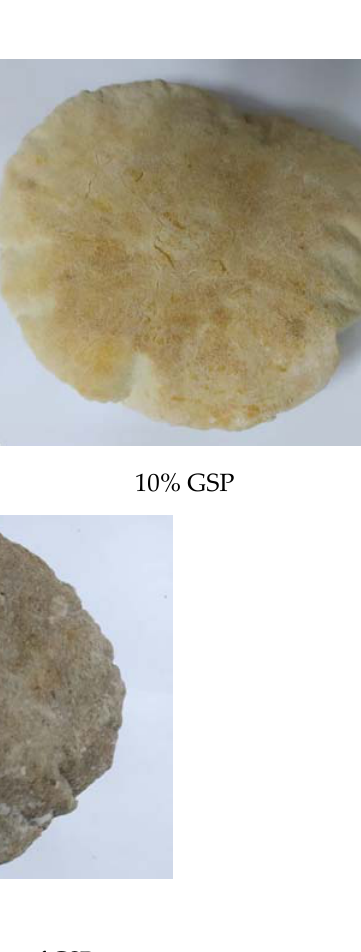
Figure 7. Balady bread supplemented with different ratios of GSP.